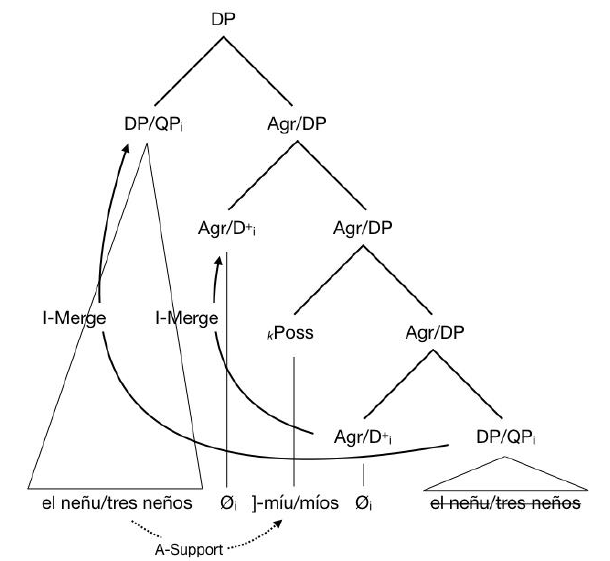
Figure 6. The postnominal possessive construction (Type III; e.g. el neñu míu